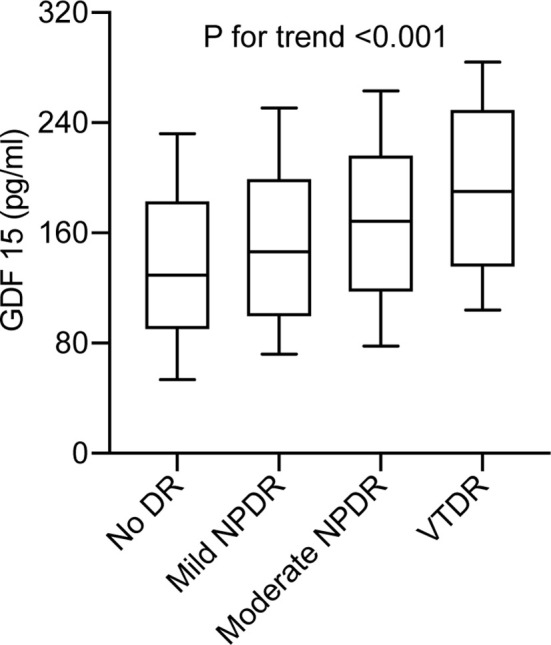
Plasma GDF-15 levels in type 2 diabetes without DR compared with patients with mild non-proliferative DR (NPDR), moderate NPDR, or vision-threatening DR (VTDR). Boxes represent the inter-quartile range, with the median superimposed as a horizontal line. Error bars indicate ranges of plasma GDF-15 levels. P < 0.001 for trend.